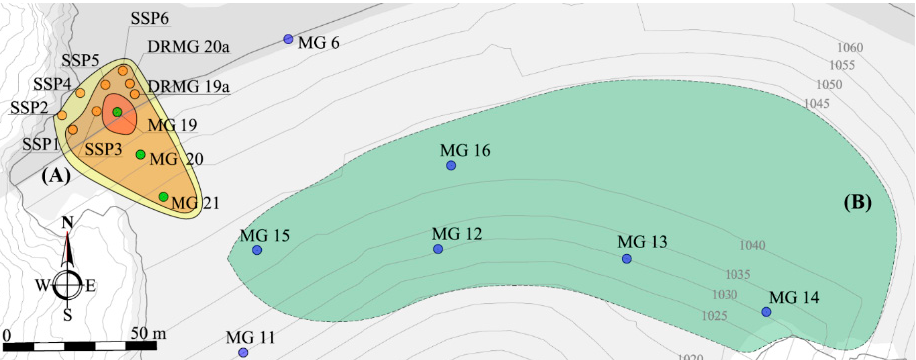
Figure 3. The area of observed maximum settlement ( A ) and the associated points SSP1 to SSP6, points MG19 to MG21, point DRMG19a, and point DRMG20a. Re-established points MG11 to MG16 and area of elevated cofferdam body are shown ( B ).